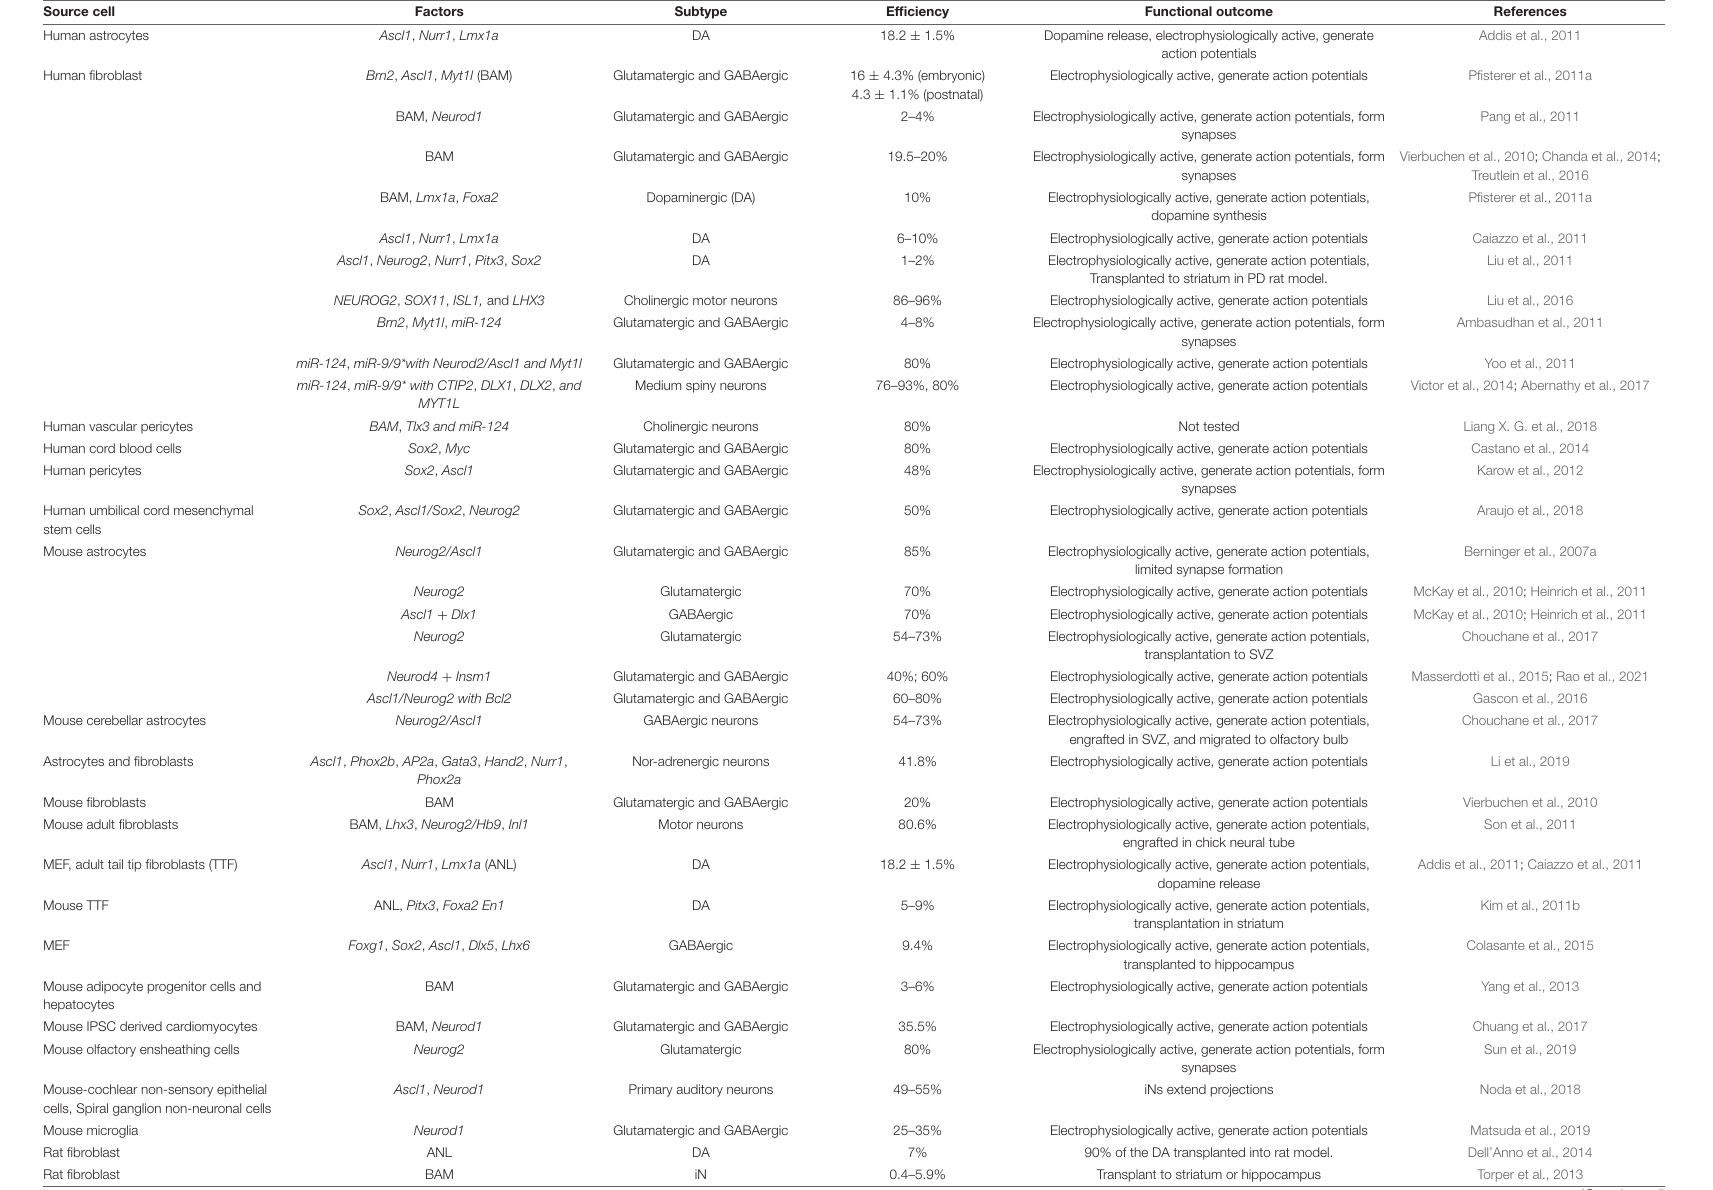
TABLE 1 | In vitro